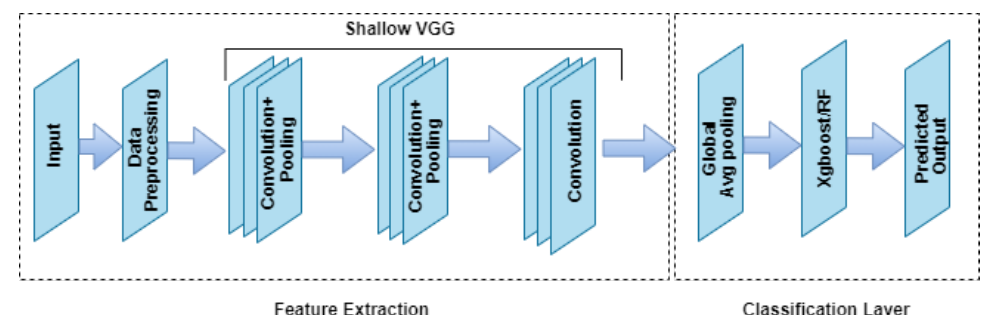
Figure 3. Proposed shallow VGG